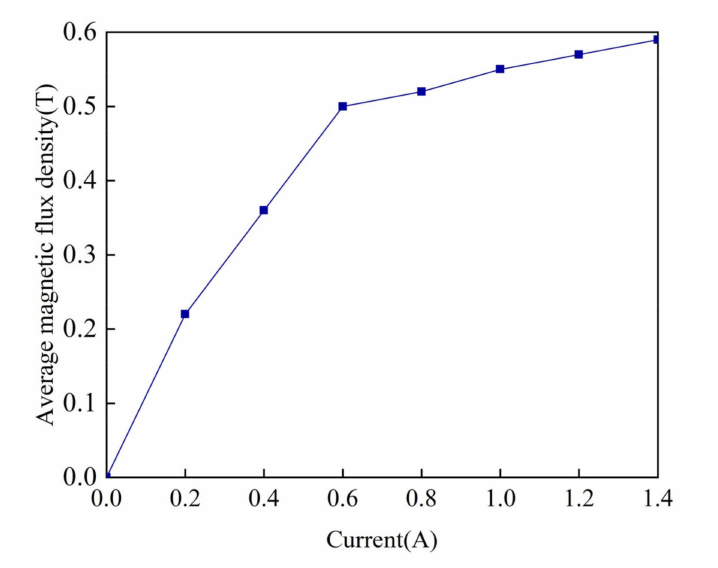
Figure 9. Variation curve of average magnetic flux density with current.